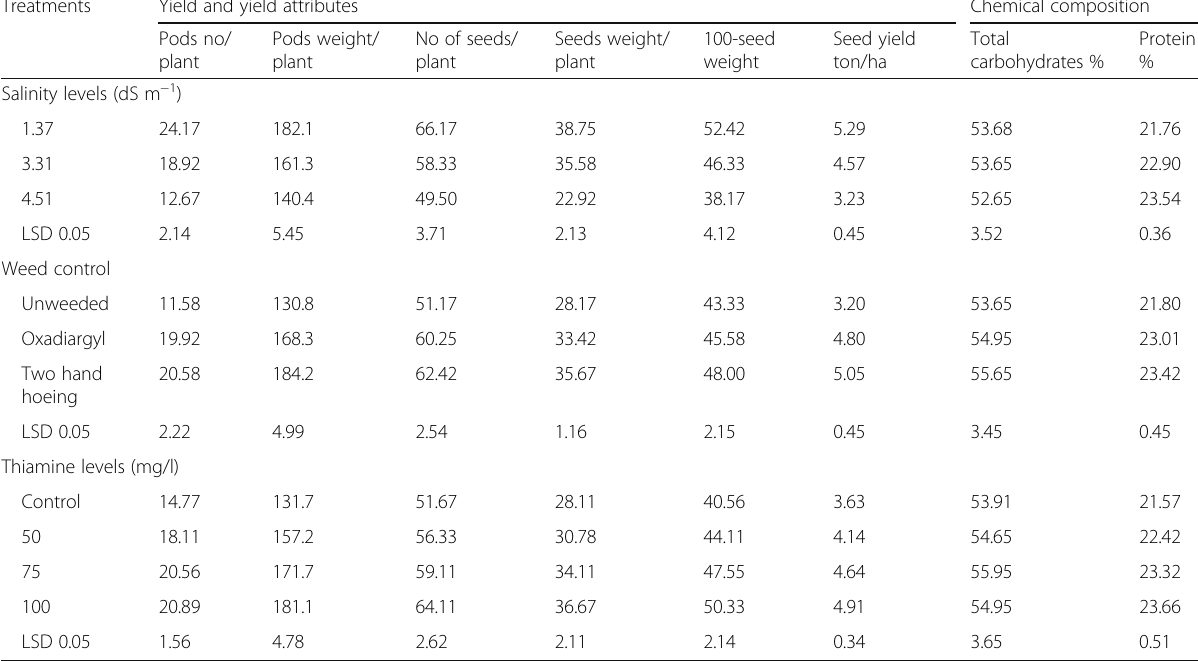
Table 5 Effect of Effect of weed control and thiamine levels on yield, yield attributes, and chemical composition of faba bean seeds under salinity condition (combined analysis of two seasons) Treatments Yield and yield attributes Chemical